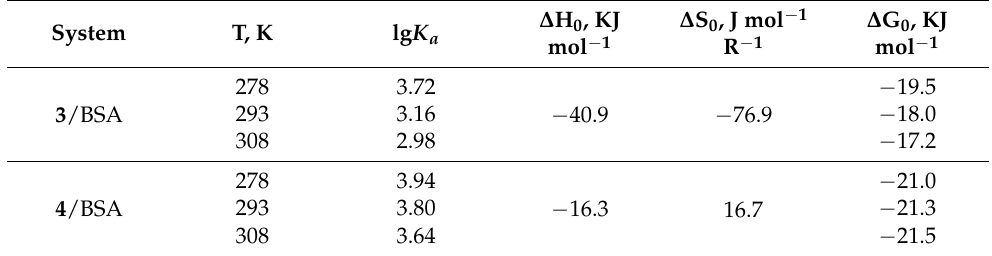
Table 3. Calculated parameters of 3 /BSA and 4 /BSA associates at different testing temperatures (278, 298, 308 K) at PBS (pH